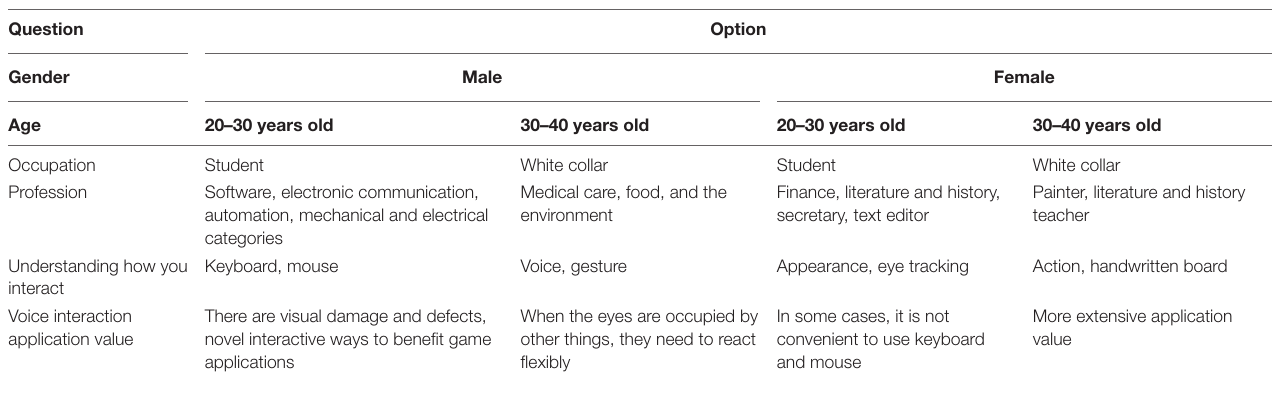
TABLE 4 | The AI voice interaction questionnaire